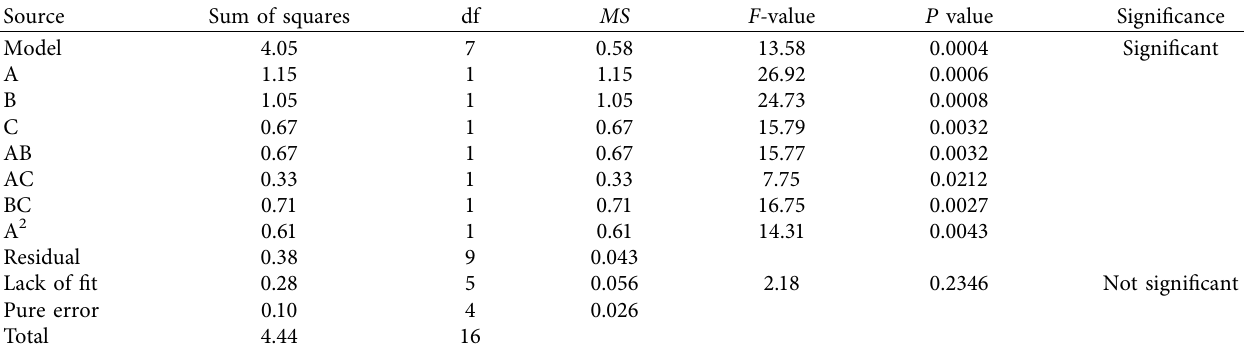
Table 7: The variance